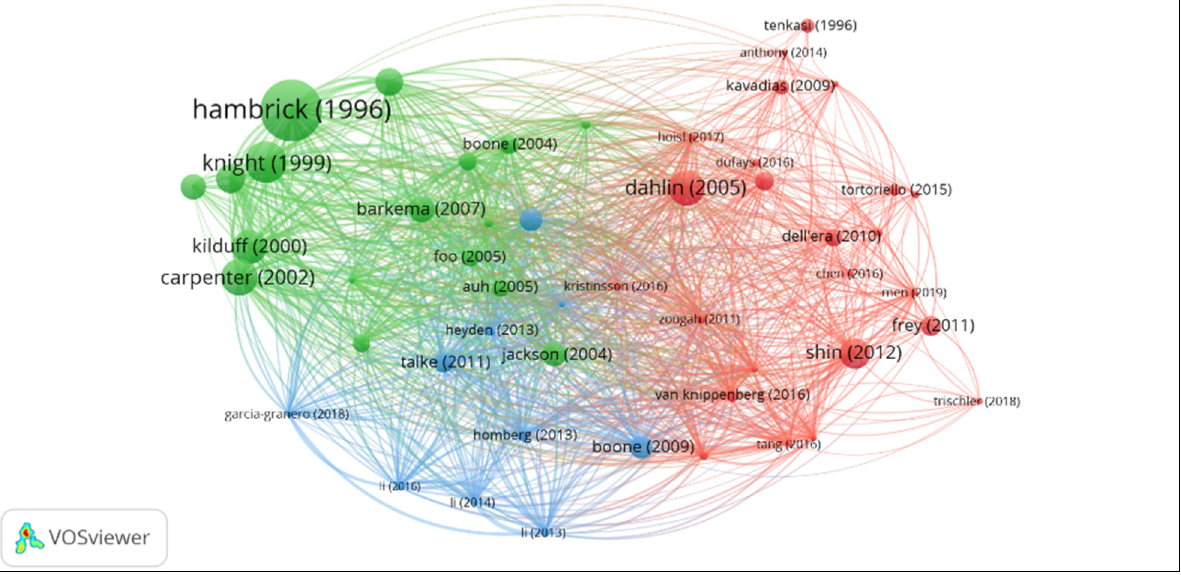
Figure 3. Cluster network. Cluster 1: Team Knowledge Diversity Cluster 2: Diversity Effects Cluster 3: Desirable Outcomes of Diversity.